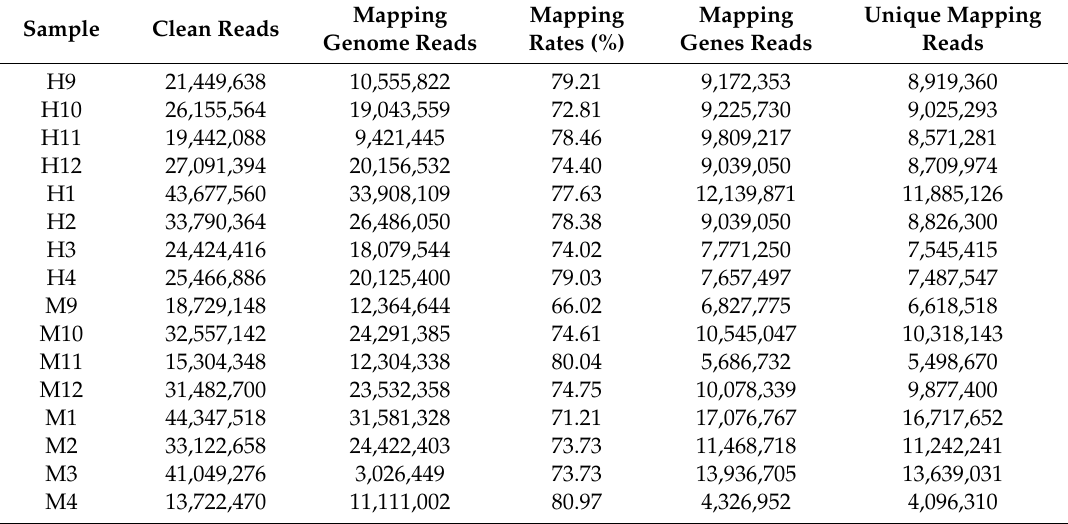
Table 2. The results of sample mapping to the reference